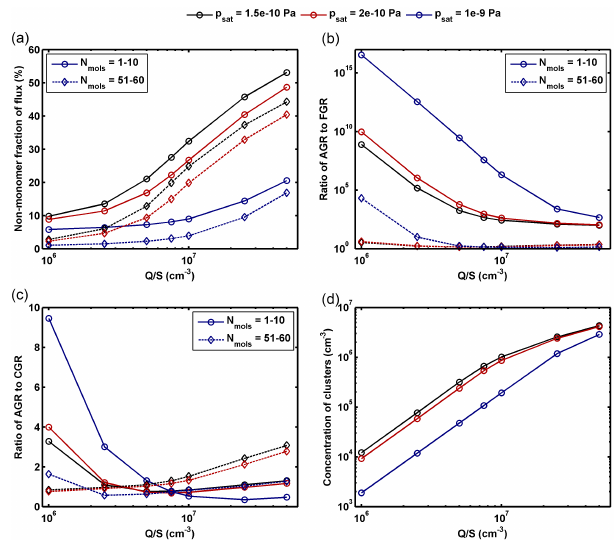
Figure 5. The results of the simulations with different saturation vapor pressures ( p sat ; shown as different colors) and different ra- tios of monomer source rate to the loss coefficient ( Q/S ; shown on the x axis) in the smallest size bin (solid line) and in the largest size bin (dashed line): (a) the non-monomer fraction of the flux; (b) the ratio of the appearance time growth rate (AGR) to the flux- equivalent growth rate (FGR); (c) the ratio of the appearance time growth rate to the growth rate calculated based on irreversible va- por condensation (CGR); (d) the steady-state concentration of all clusters